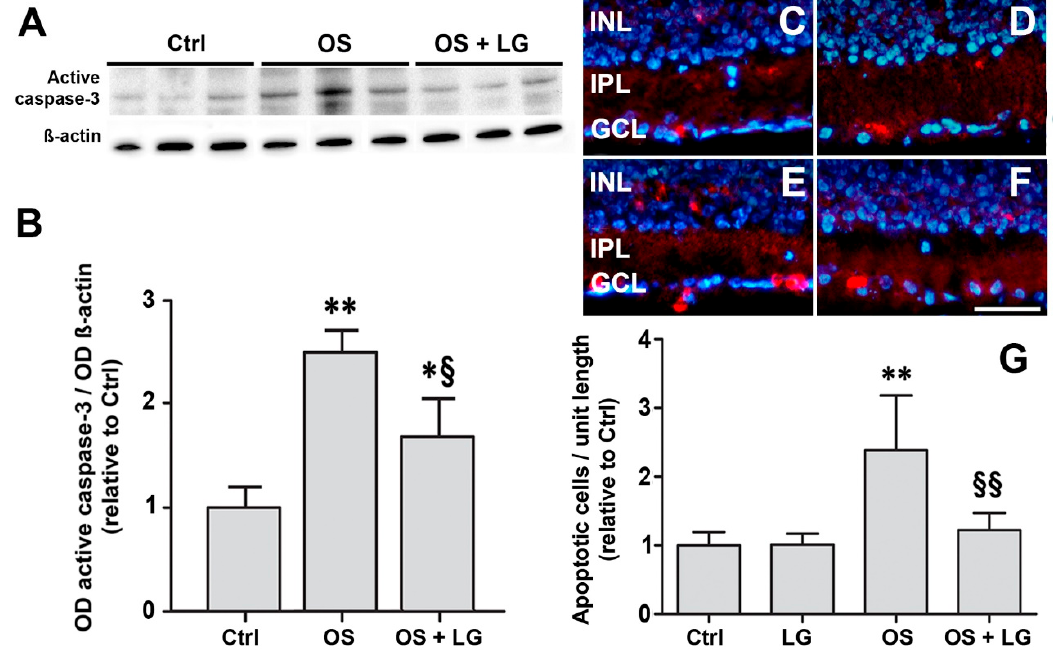
Figure 2. Ex vivo retinal explants cultured for 5 days. ( A ) Western blots showing immunoreactive bands of active caspase-3 and of ß-actin, used as an internal standard, in control explants and in OS-induced explants with or without 0.67 µ g/mL LG. ( B ) Quantitative analysis of the optical density (OD) of the immunoreactive bands. Each column represents mean ± SD. * p < 0.05 vs. Ctrl; ** p < 0.01 vs. Ctrl; § p < 0.05 vs. OS; n = 3. Power value: 0.99. ( C – F ) Representative immunofluorescence images showing the presence of active caspase-3 immunolabeled cells in the inner nuclear layer (INL) and in the ganglion cell layer (GCL) in coronal sections of control explants ( C ), explants treated with 0.67 µ g/mL LG alone ( D ), OS-induced explants ( E ), OS-induced explants incubated with 0.67 µ g/mL LG ( F ). IPL: inner plexiform layer. 4 ′ ,6-diamidino-2-phenylindole (DAPI) counterstain. Calibration bar, 50 µ m. ( G ): Quantitative analysis of the number of immunostained cells. Each column represents mean ± SD. ** p < 0.01 vs. Ctrl; §§ p < 0.01 vs. OS; n = 4. Power value: 0.91.